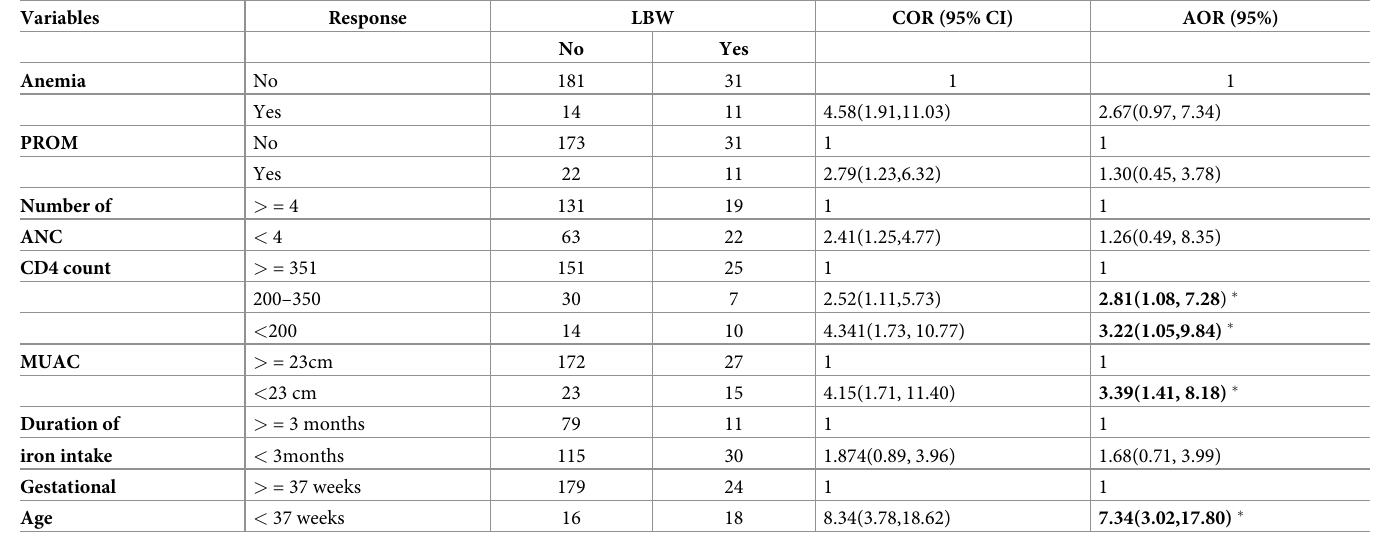
Table 5. Bivariable and multivariable logistic regressions of factors associated with LBW among HIV positive mothers.